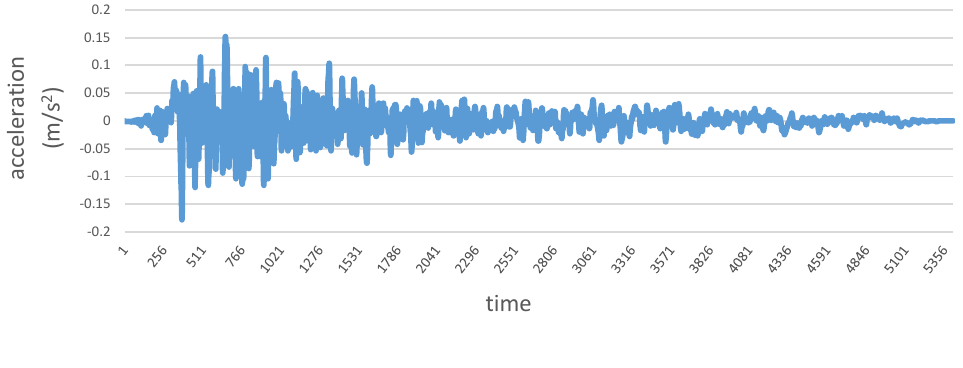
Fig. 2. time-acceleration records of earthquake